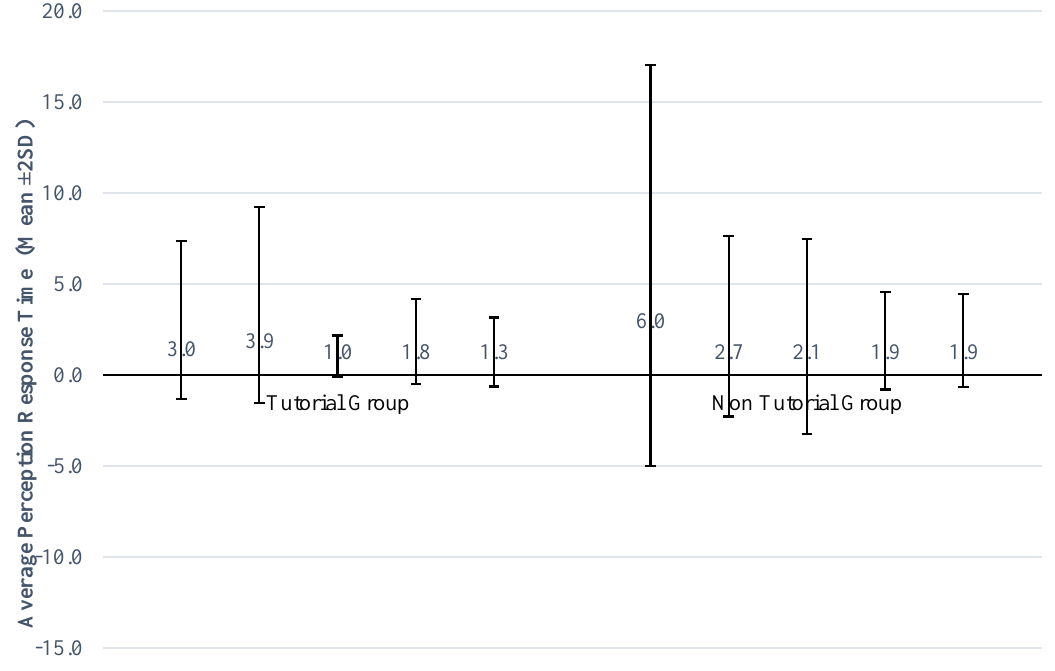
Figure3. Standarddeviationerrorbarofcollisionsfromeachsessionvs. tutorialandnon-tutorialgroups. 2019 , 12 , x Figure 3 . Standard deviation error bar of collisions from each session vs. tutorial and non-tutorial groups.